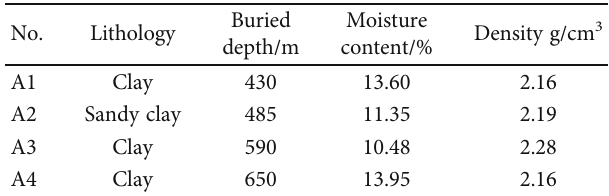
Table 1: Sampling distribution and basic parameters of the frozen soil in Zhaogu No. 2